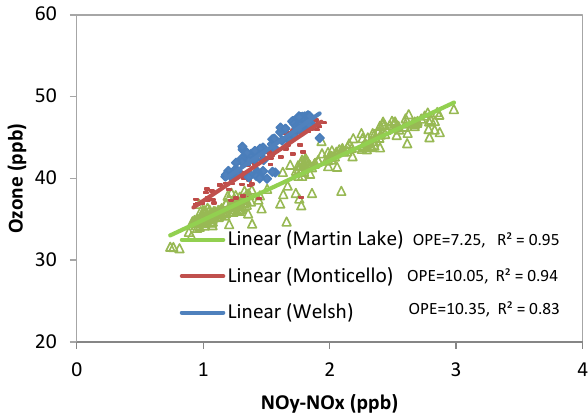
Fig. 9. O 3 versus NO y -NO x from the transects of Martin Lake (Ma-6, plume age of 2.0h), Monticello (Mo-4, plume age of 2.4h), and Welsh (We-4, plume age of 2.7h). The slopes from the least square fits indicate the observation-based estimates of OPE from each plume transect.